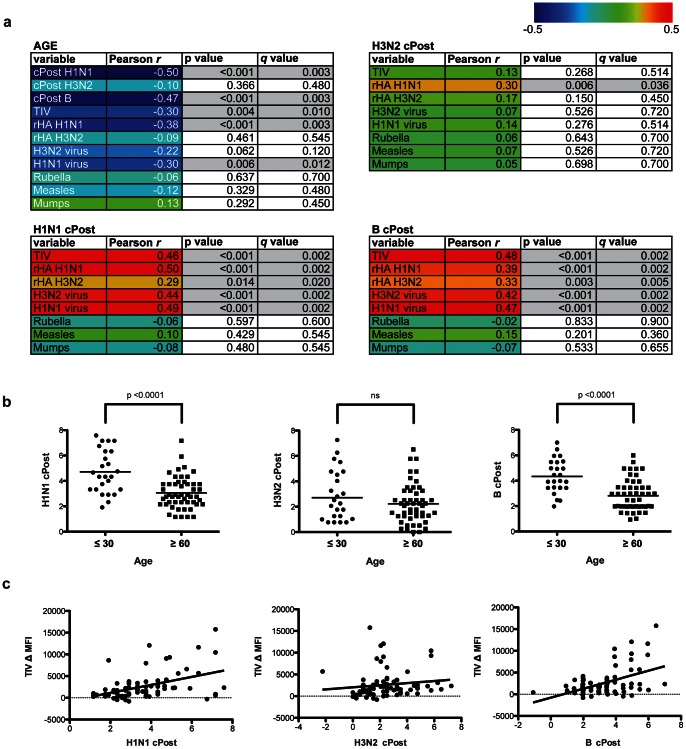
Correlation of age and post-vaccine neutralization titer with influenza whole-protein array reactivity.(a) Table displaying correlation coefficient (Pearson r), p value and false discovery rate (FDR) q value of whole-protein influenza antigen array reactivity with age and corrected post-vaccine neutralization titer (cPost) for H1N1, H3N2 and B influenza strains. Correlations with a p value <0.05 are highlighted in gray. Color scale represents the direction and magnitude of the Pearson r correlation coefficient. (b) Comparison of age and cPost H1N1, H3N2 and B influenza strain neutralization titer. P values were generated using a two-tailed student’s T test. (c) Dot plots displaying relationship between cPost neutralization titer (x axes) and change in array reactivity (MFI) to Fluzone trivalent influenza vaccine (TIV Δ, y axes). The line in each graph displays the least-squares linear regression of cPost titer and TIV Δ MFI, and corresponds to the Pearson r values shown in a.